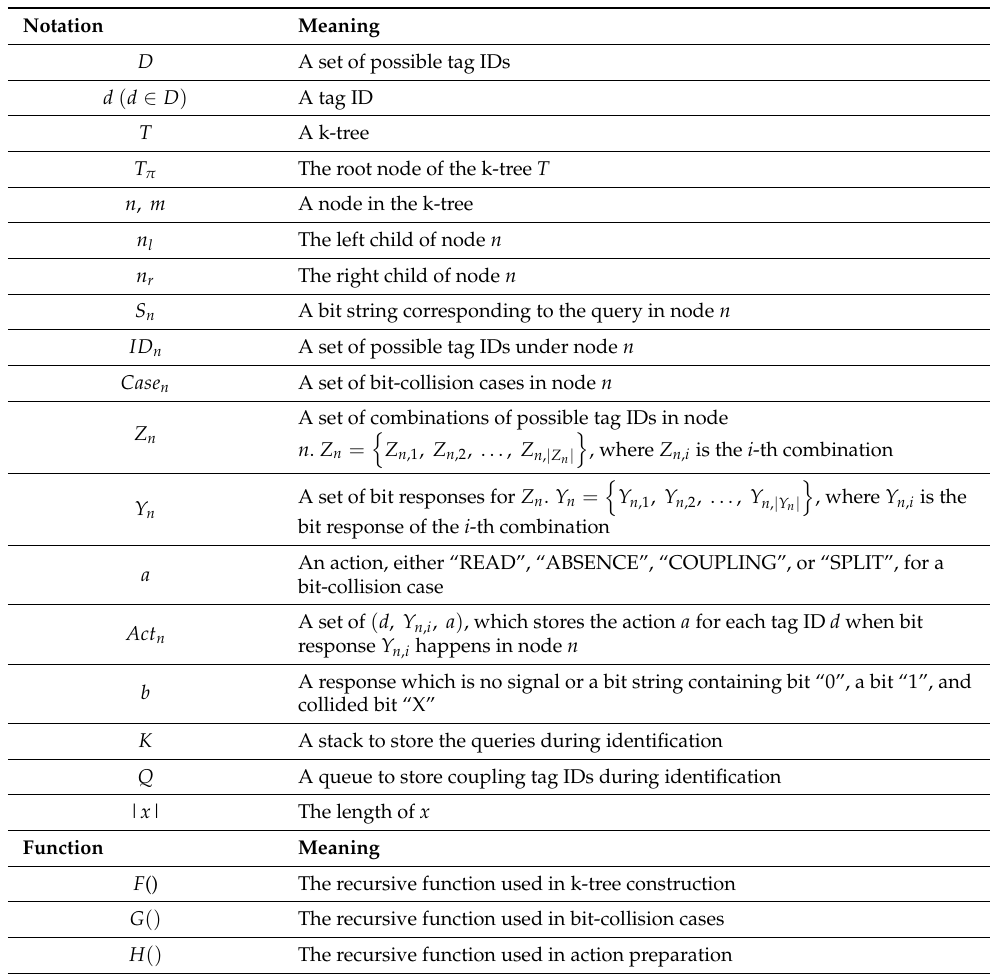
Table 1. Notations and their meanings used in